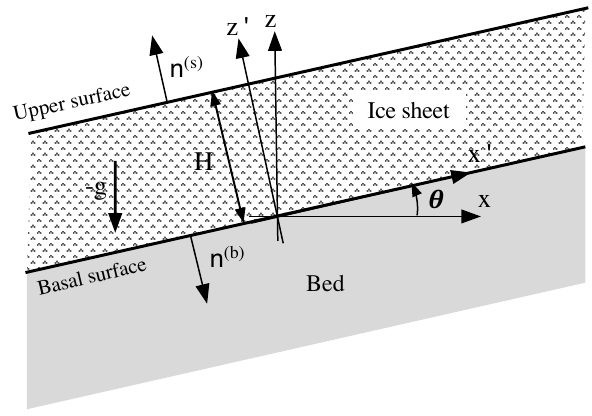
Fig. 2. The simple sliding ice sheet test problem configuration, showing the transformed (rotated) coordinate system, (cid:0) x 0 , z 0 (cid:1)